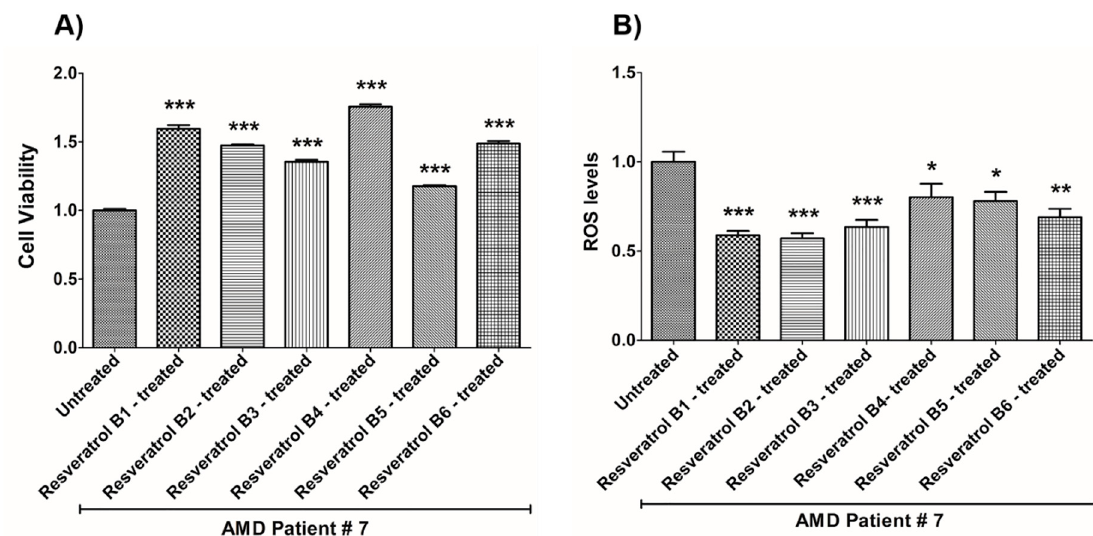
Figure 7. Effects of resveratrol formulations on cell viability ( A ) and ROS levels ( B ) in AMD patient